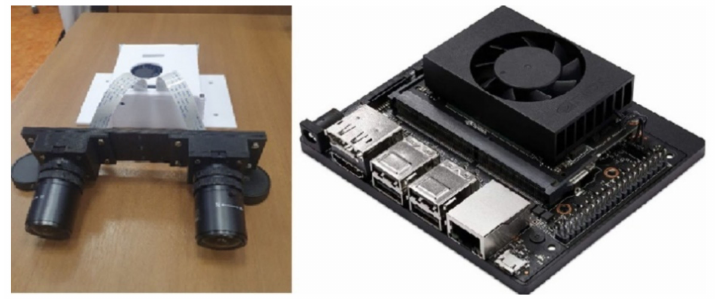
Figure 3. Binocular vision system.